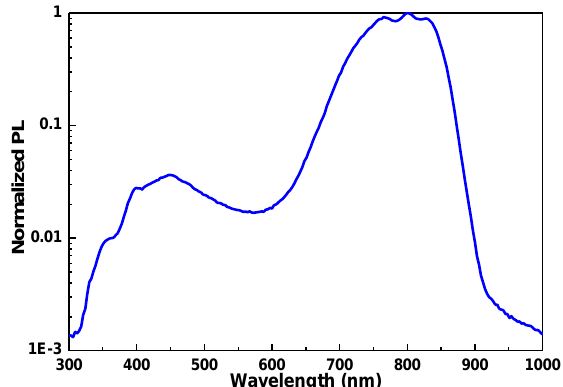
Figure 2. The photoluminescence (PL) spectrum of silicon quantum dots (Si-QDs) in Si-implanted SiO 2 host matrix.